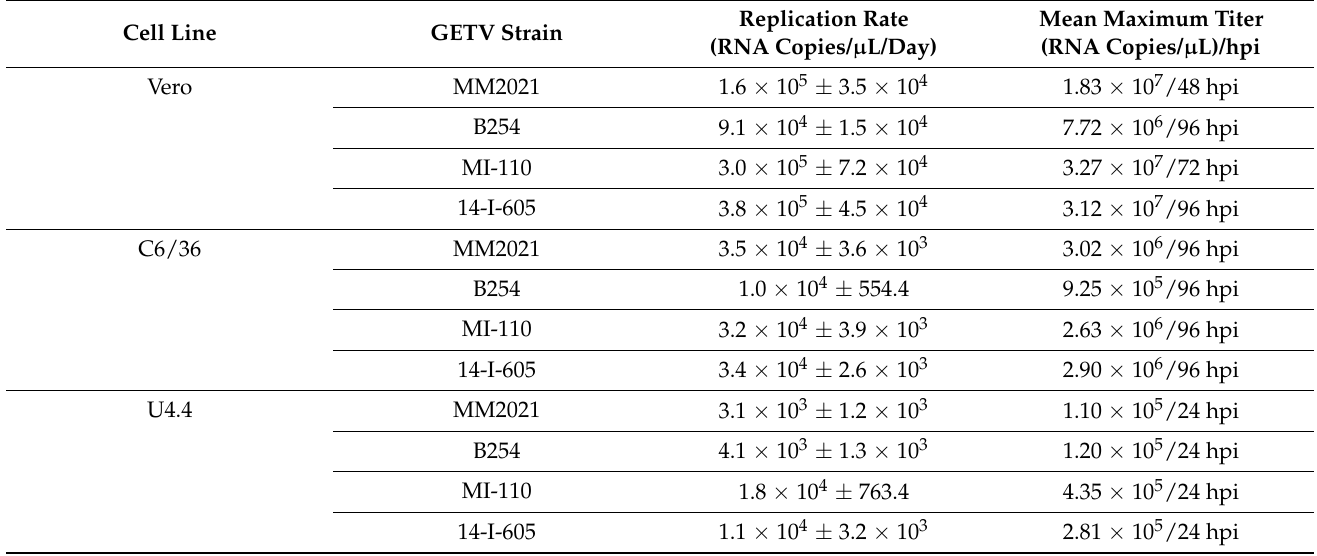
Table 2. Replication rates and mean maximum titers of various GETV strains in Vero, C6/36, and U4.4